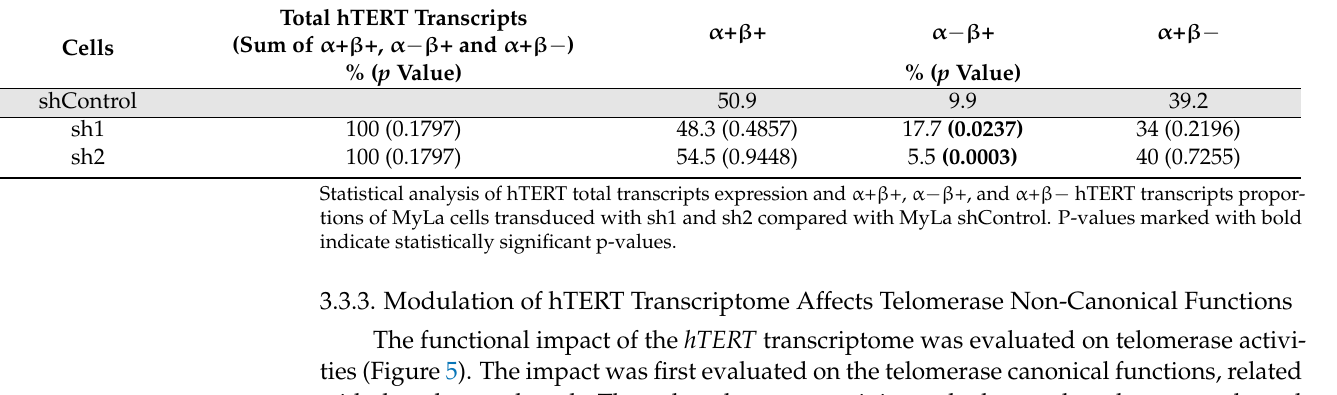
Table 4. hTERT transcripts expression analysis in transduced MyLa